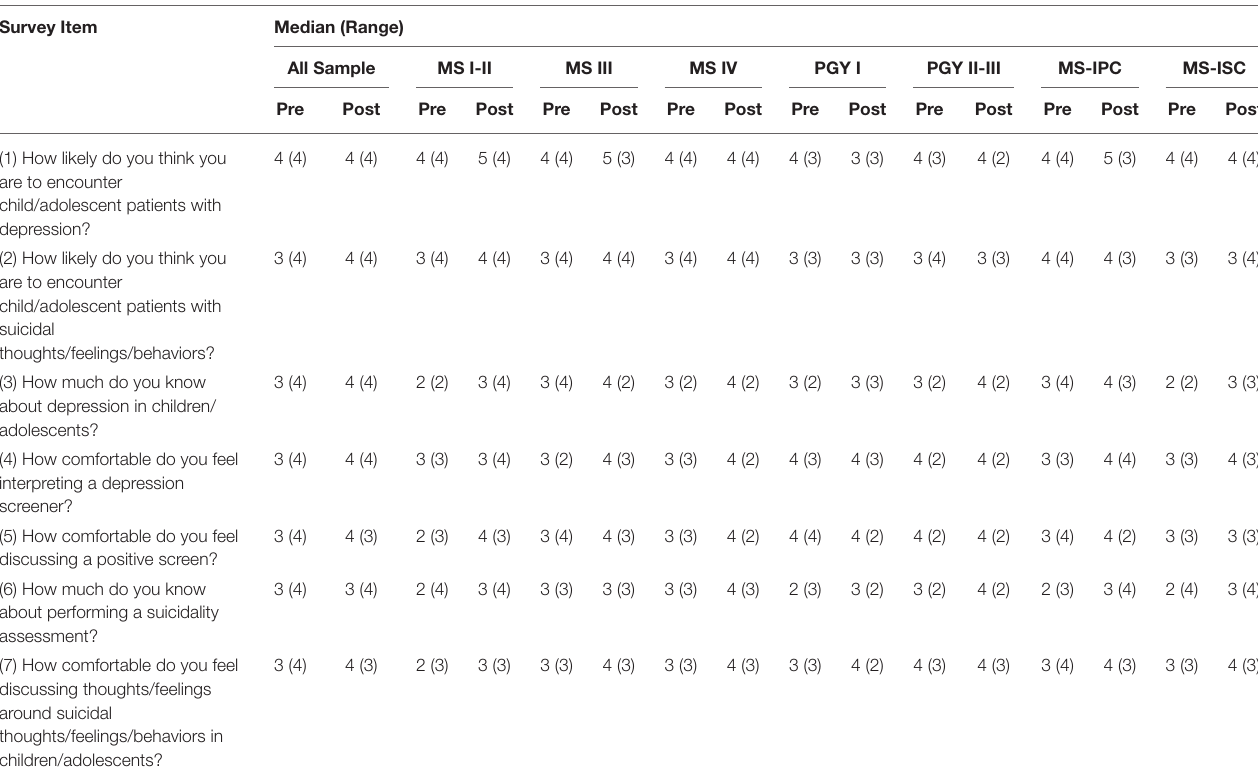
TABLE 2 | Item-level survey descriptive statistics for all participants ( N = 149) by level and medical specialty area. Survey Item